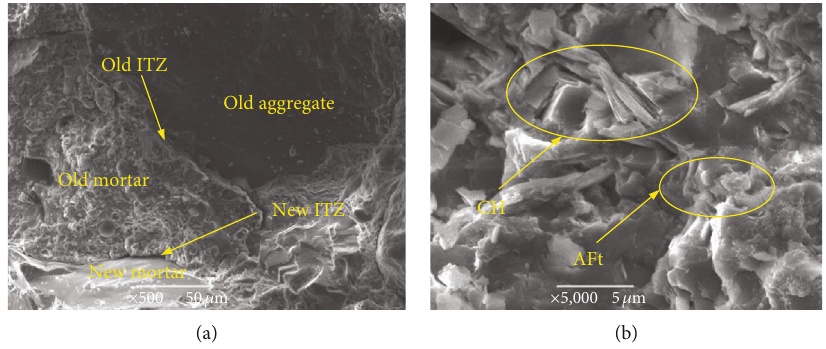
Figure 11: Microstructure of RAC: (a) classi fi cation ITZs of RAC and (b) hydration products.